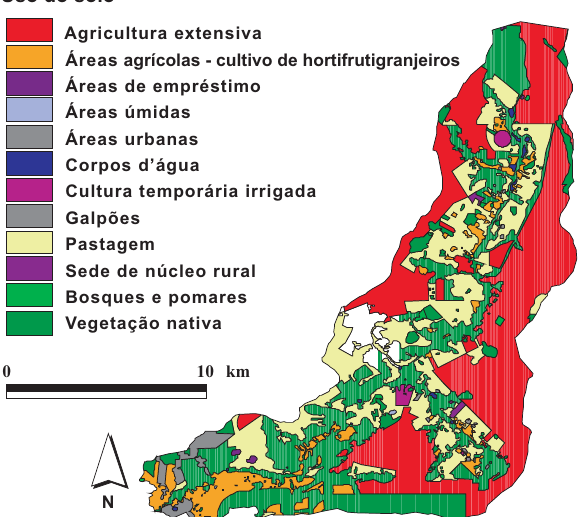
Figura 1. Uso do solo na bacia do rio Pipiripau. As coordenadas UTM nas extremidades da bacia